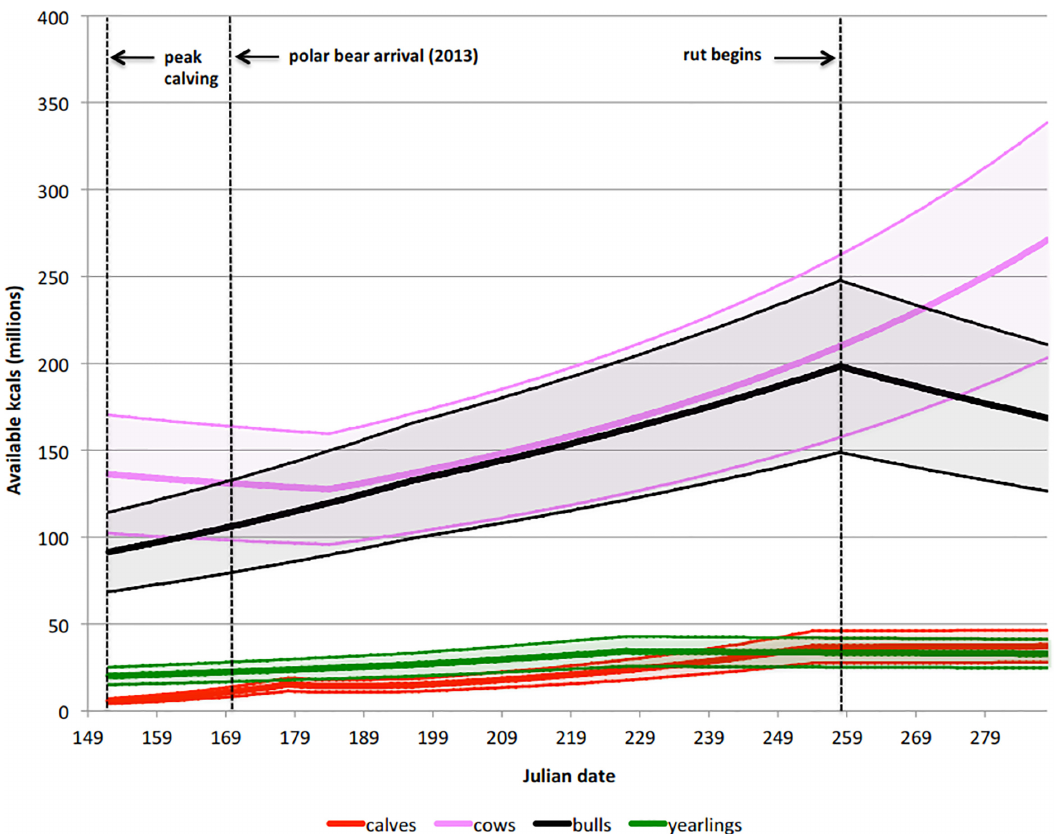
Fig 3. The total available energy from different sex and age classes of caribou on the summer calving grounds on the Cape Churchill Peninsula. If the ice-free season expands to 180 days, polar bears are projected to come ashore prior to the onset of calving, which is currently 1 June, and have access to all the available energy